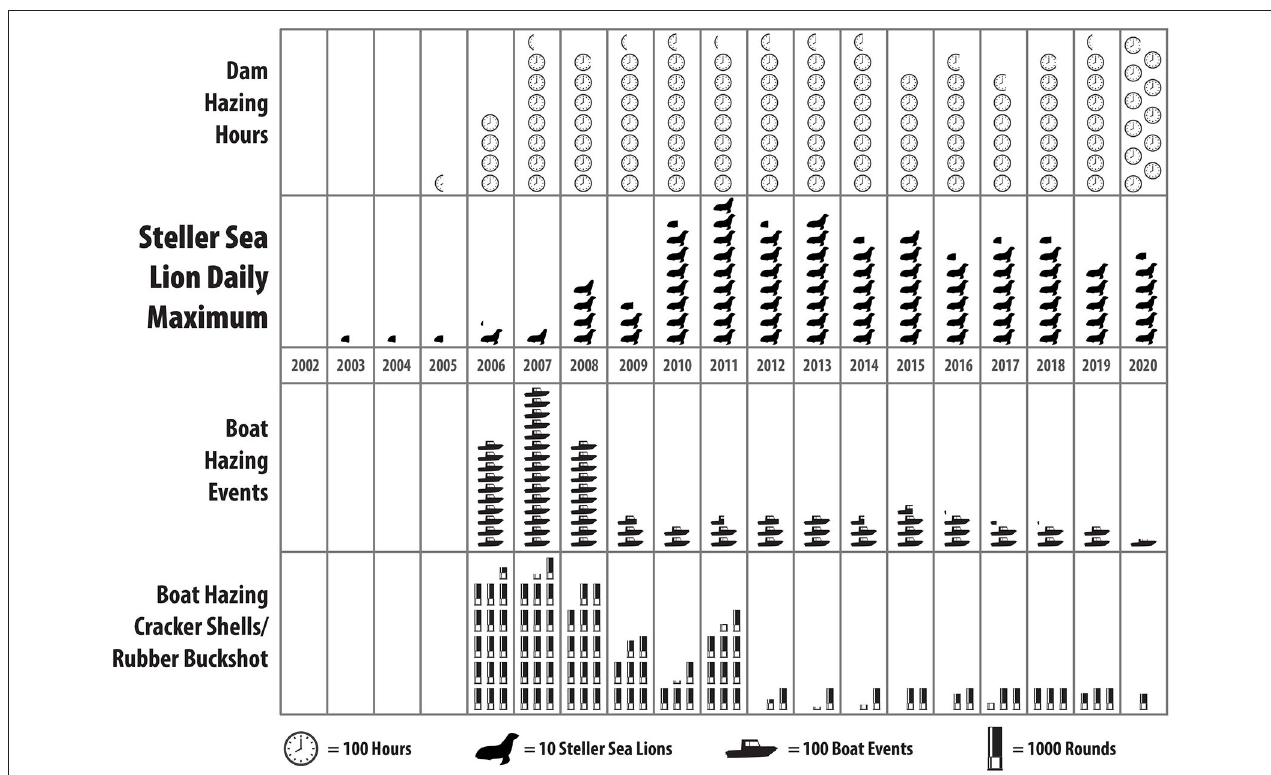
FIGURE 2 | Non-lethal deterrent effort (Dam-and Boat Based hazing and the number of munitions spent to dissuade animals) and the number of Steller Sea Lions at Bonneville Dam between 2002 and 2020.